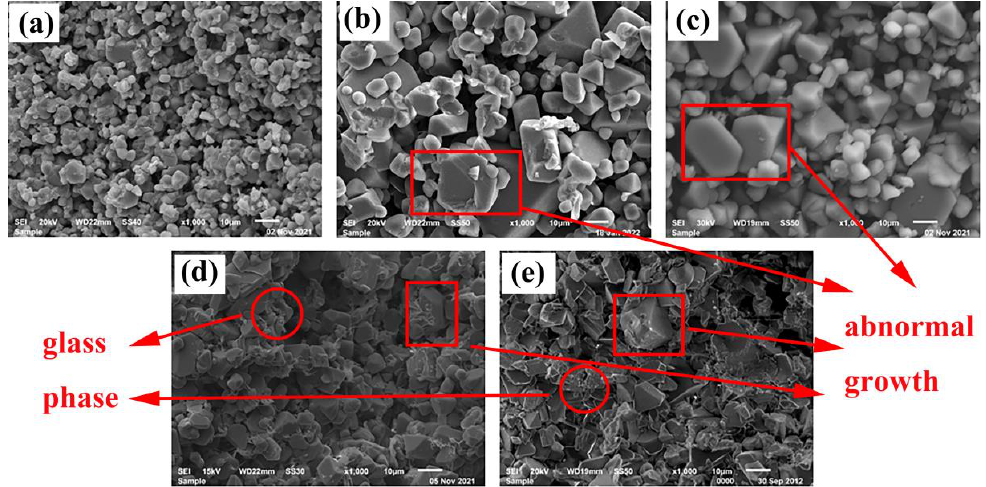
Figure 5. SEM images of the samples treated at 1100 °C ( a ) B0.9, ( b ) B1, ( c ) B1.1, ( d ) B1.2, and ( e ) B1.3. Table 2. The content of H 3 BO 3 and H 3 PO 4 that theoretically unreacted.